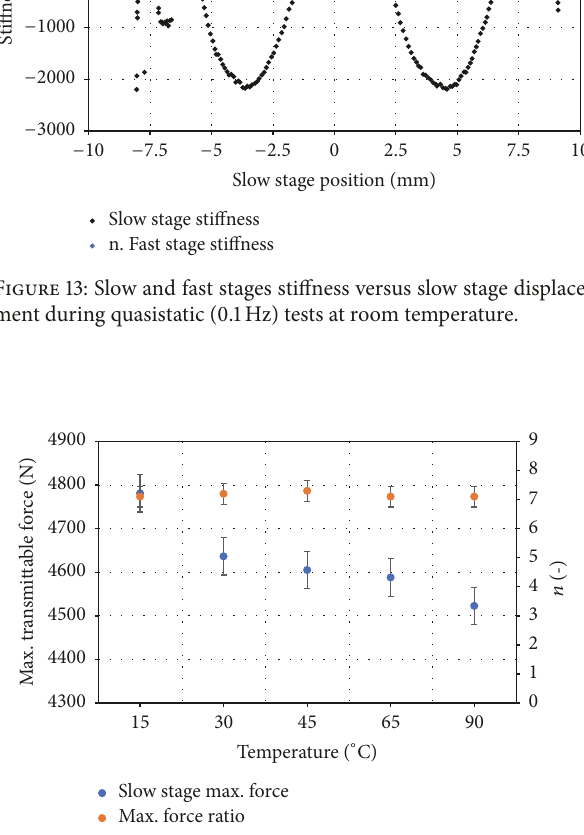
Figure 14: Maximum slow stage force versus experimental force.